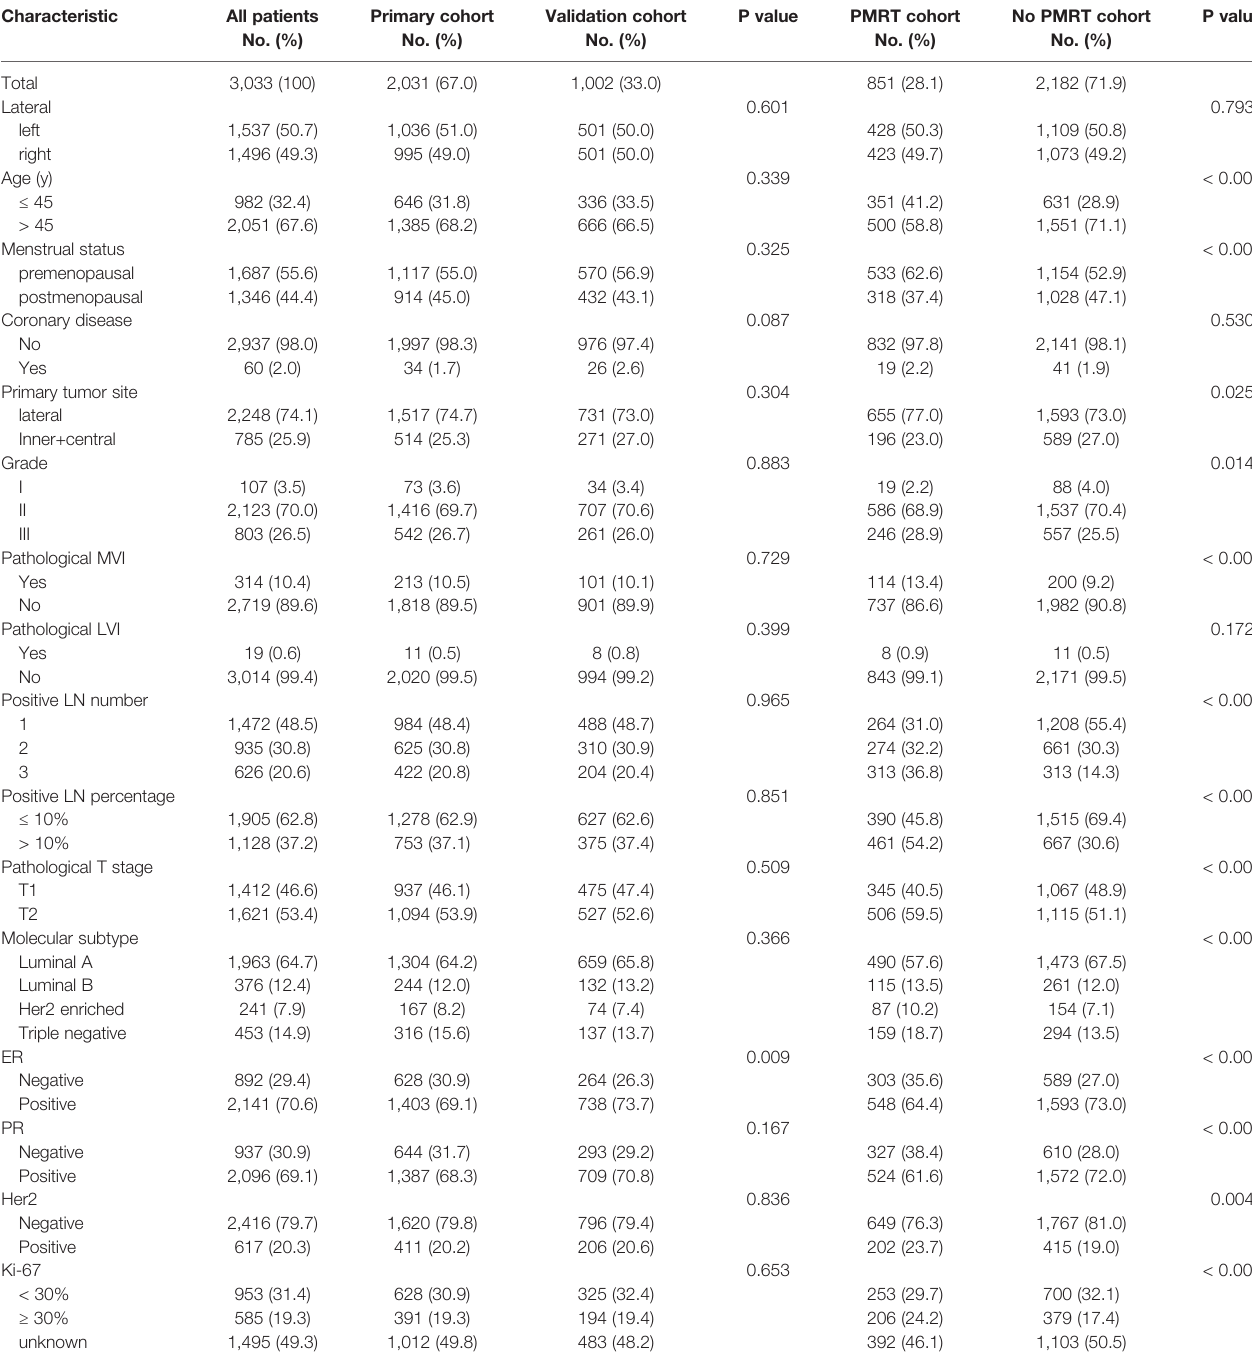
TABLE 1 | Clinical characteristics of patients with pT1N1M0 breast cancer. Characteristic All patients No.